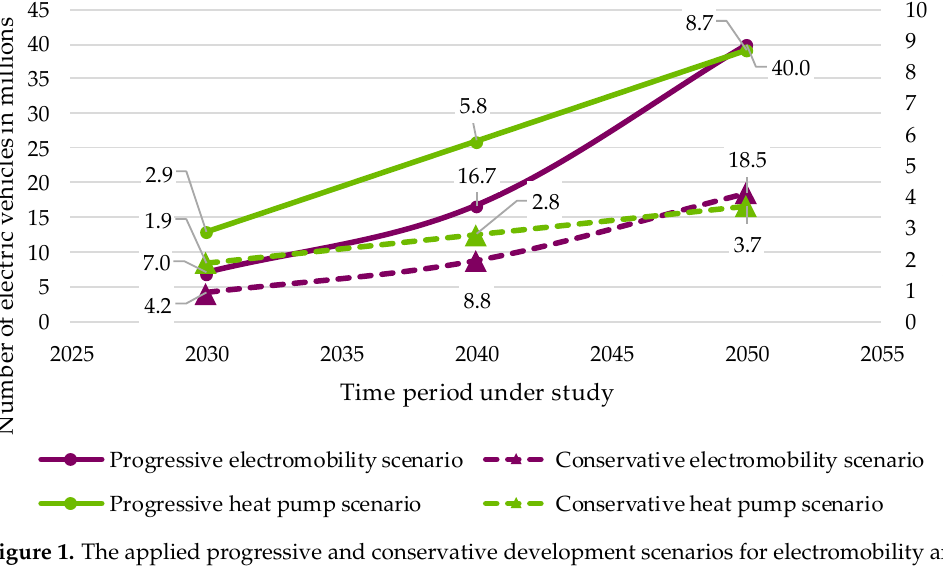
Figure 1. The applied progressive and conservative development scenarios for electromobility and heat pumps in Germany based on [41].